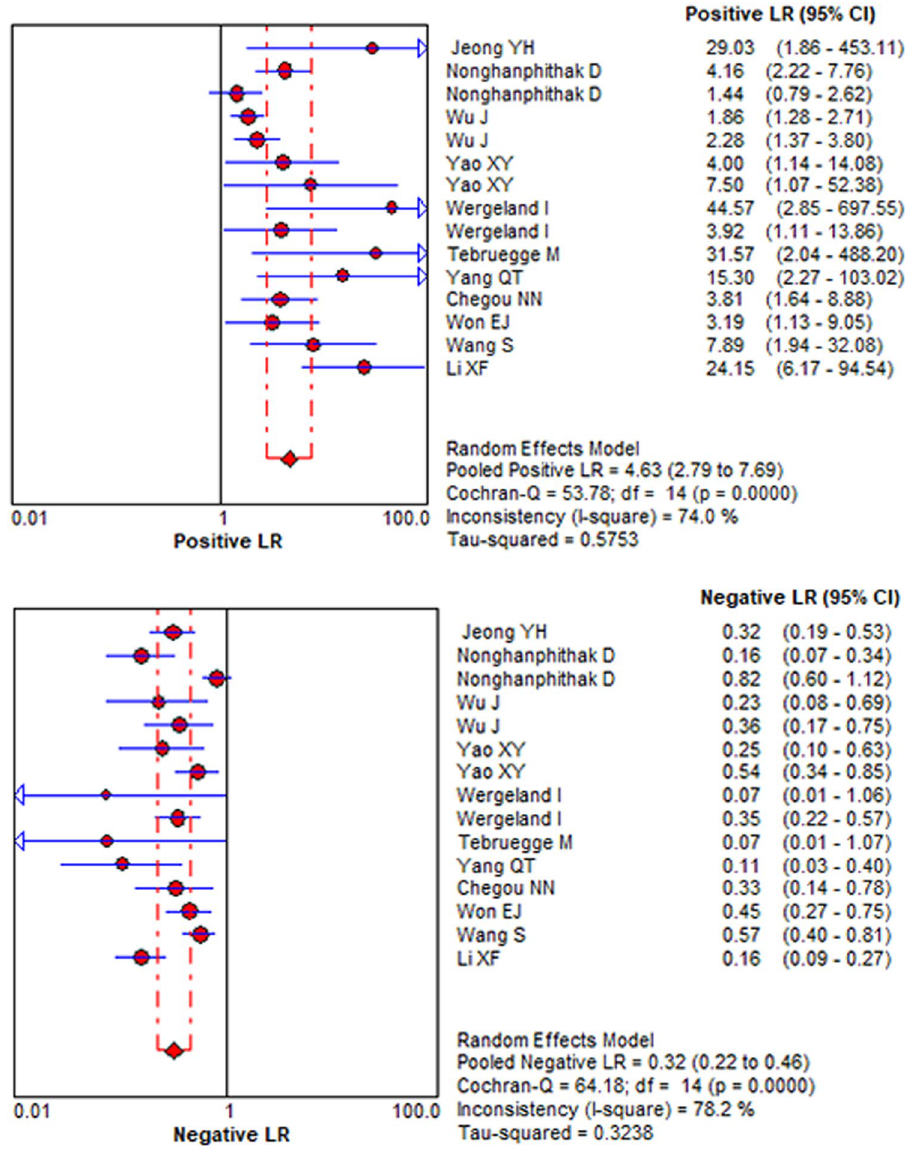
Figure 3. The forest plots of positive LR and negative LR of IP-10 for differentiating ATB from LTBI. The pooled PLR and NLR of IP-10 were 4.63 (95% CI: 2.79–7.69, I 2 = 74.0%) and 0.32 (95% CI: 0.22–0.46, I 2 = 78.2%),